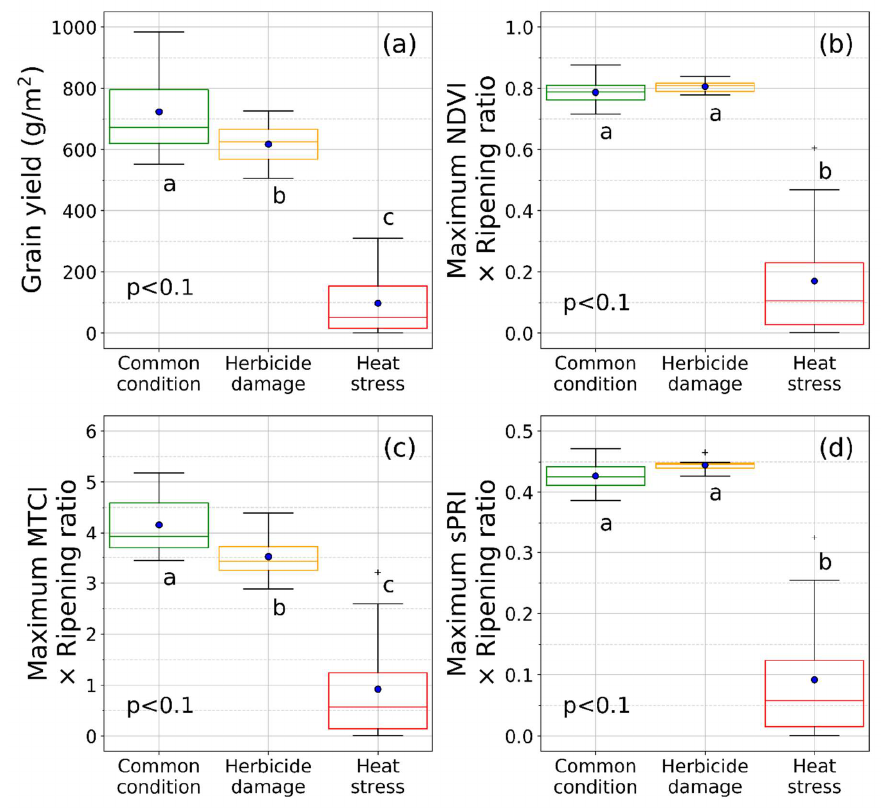
Figure 12. Boxplot of ( a ) grain yield, ( b ) maximum NDVI value × ripening ratio, ( c ) maximum MTCI value × ripening ratio, and ( d ) maximum sPRI value × ripening ratio according to stress values. The maximum vegetation value meant the maximum value of vegetation index during growth period paddy rice.